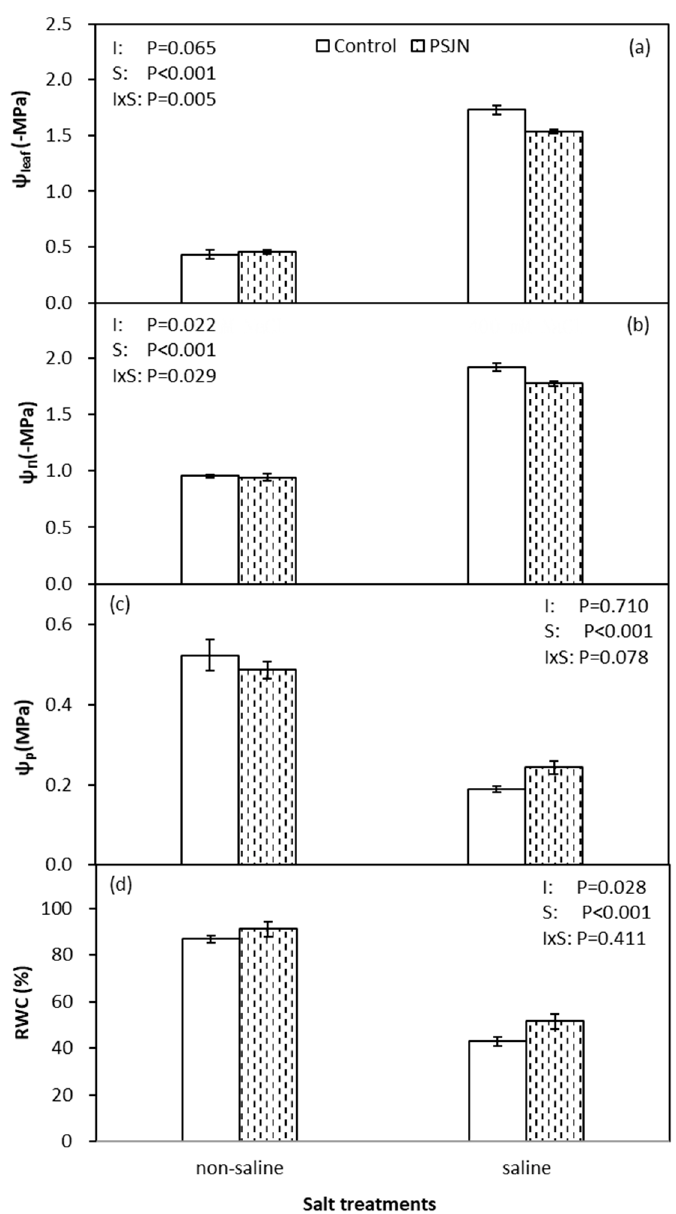
Figure 2. Leaf potential ( Ψ l ) ( a ), osmotic potential ( Ψ π ) ( b ), turgor potential ( Ψ p ) ( c ) and relative water content (RWC) ( d ) of quinoa a ff ected by bacterial inoculation in non-saline (0 mM NaCl) and saline (400 mM NaCl) irrigations. PsJN indicates Burkholderia phytofirmans PsJN. I and S indicate inoculation and salinity treatments, respectively, and I × S indicates the interaction. Error bars indicate S.E. ( n =